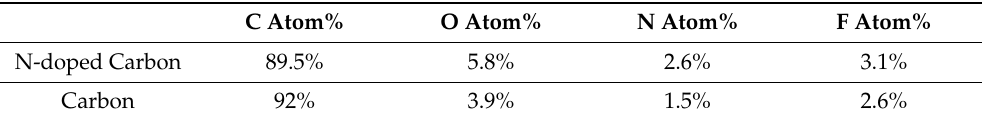
Figure 2. ( A ) XPS spectra of the C − 800 and NC − 800 samples; ( B ) C1S XPS spectra of the NC − 800 samples; ( C ) N1S XPS spectra of the NC − 800 samples; ( D ) Raman spectra of NC − 800 and C − 800; ( E ) SEM images of NC − 800; ( F ) nitrogen sorption isotherms of NC − 800 and C − 800. Table 1. The elemental composition of carbon and N-doped carbon.